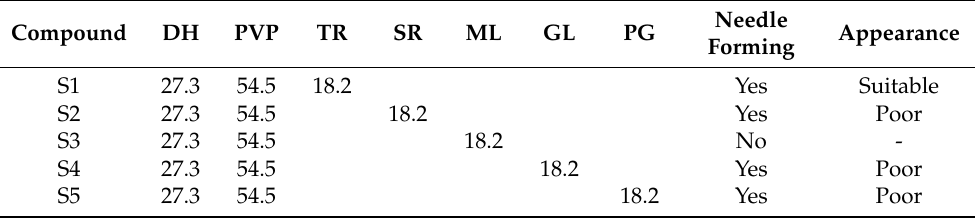
Table 1. The composition of donepezil HCl (DH)-loaded DMN patch containing various plasticizers (% w / w